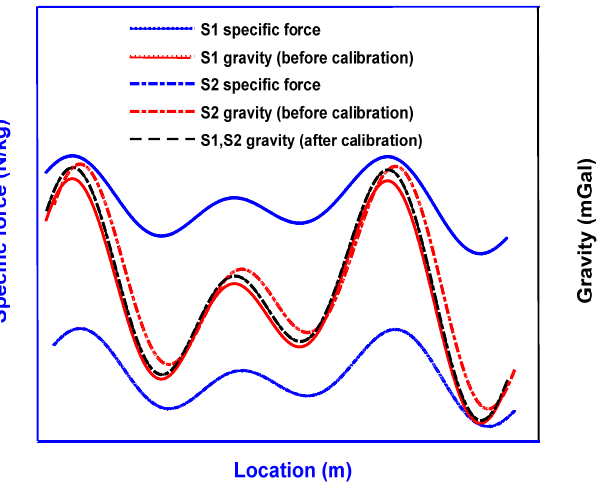
Figure 2. Schematic diagram illustrating the calibration principle. Successful calibration will bring both S1 and S2 sequences to the same real gravity anomaly curve, as shown in the black dashed line.